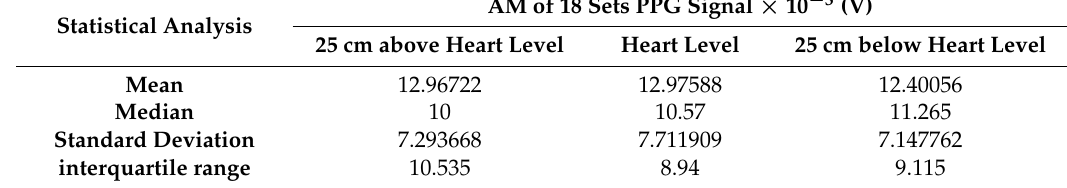
Table 4. Mean, Median, Standard Deviation, and Interquartile Range of AM from 18 sets of PPG signal at Different VHD